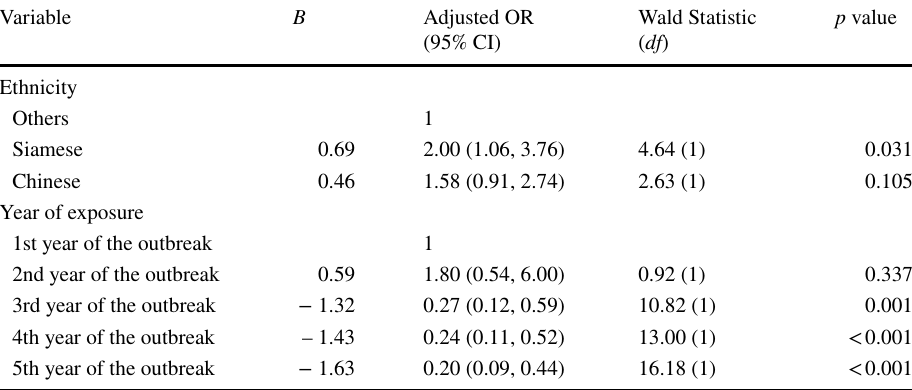
The backward method was applied No multicollinearity and